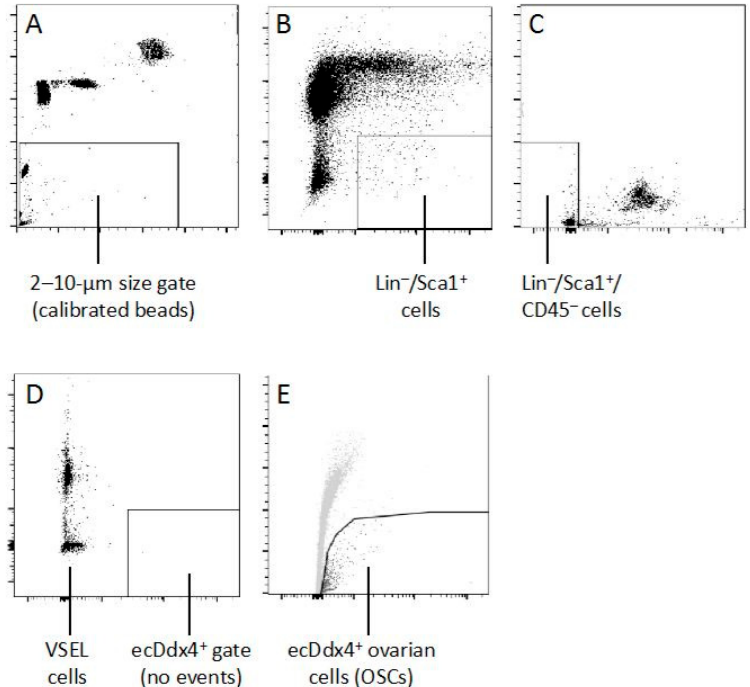
Figure 3. Mouse VSEL stem cells do not express externalized Ddx4. ( A ) To identify VSEL stem cells by FACS, size gates were initially set for 2–10 µm using calibrated beads. ( B , C ) Following dead cell exclusion, bone marrow-derived VSEL stem cells were identified in the 2–10 µm size gate as Lin − /Sca1 + /CD45 − events, first by gating Lin − /Sca1 + cells followed by exclusion of CD45 + cells from this subpopulation (for additional details, see [129]). ( D ) Further analysis of the VSEL stem cell population shown in panel C using C-terminal-directed Ddx4 antibodies demonstrates that VSEL stem cells do not express externalized Ddx4 (ecDdx4 − ). ( E ) As a positive control for the VSEL stem cell analysis shown in panel D , parallel sorting of dispersed ovaries identifies viable ecDdx4 + cells, which represent OSCs (for additional details, see [68,73,112]). D.C. Woods and J.L. Tilly, unpublished data. 5. Will Stem Cell-Derived Oocytes be of Future Value to Human Assisted Reproduction? With multiple laboratories now confirming the existence and functional characteristics of OSCs in adult human ovaries [73,97–99,101], the most important question remains. Can these cells be utilized in some fashion to enhance, prolong or restore fertile potential in women? One possibility, which involves the use of patient-matched OSC mitochondria to invigorate eggs of women with a history of poor egg and embryo quality [102,103]—in a procedure termed autologous germline mitochondrial energy transfer (AUGMENT) [143,144], has recently been reviewed in detail elsewhere [104] and, thus, will not be addressed further here. A second obvious direction for this work, based on the guiding principles of regenerative medicine, involves development and testing of autologous transplantation-based approaches for prolongation or restoration of ovarian function. The in-vivo generation of new oocytes, capable of producing functional eggs, from transplanted OSCs has been conceptually validated by multiple independent groups using rodent models [53,67,72,73,78,80,84,85]. Moreover, preliminary findings from scientists at the National Institutes of Health indicate that comparable outcomes can be achieved with adult female non-human primates [145]. As important as these efforts are, we would like to focus our closing thoughts on what